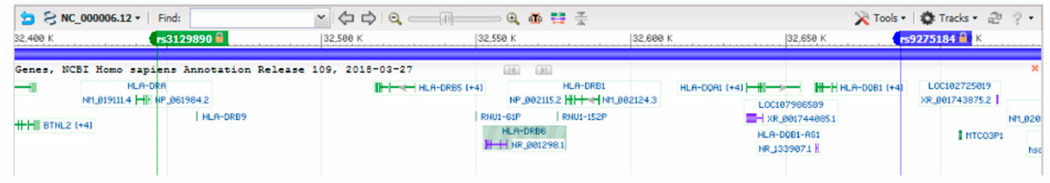
Figure 1. Genomic map of HLA-DR / DQ region in the human major histocompatibility complex (MHC) reference sequence. The map shows a slightly larger region than that phased in MERLIN. The two marked single nucleotide polymorphisms (SNPs) represent the boundaries of the phased 101 SNP haplotypes from which SNPs were “pre-triaged” for redundancy to create the initial 37-SNP haplotypes for further